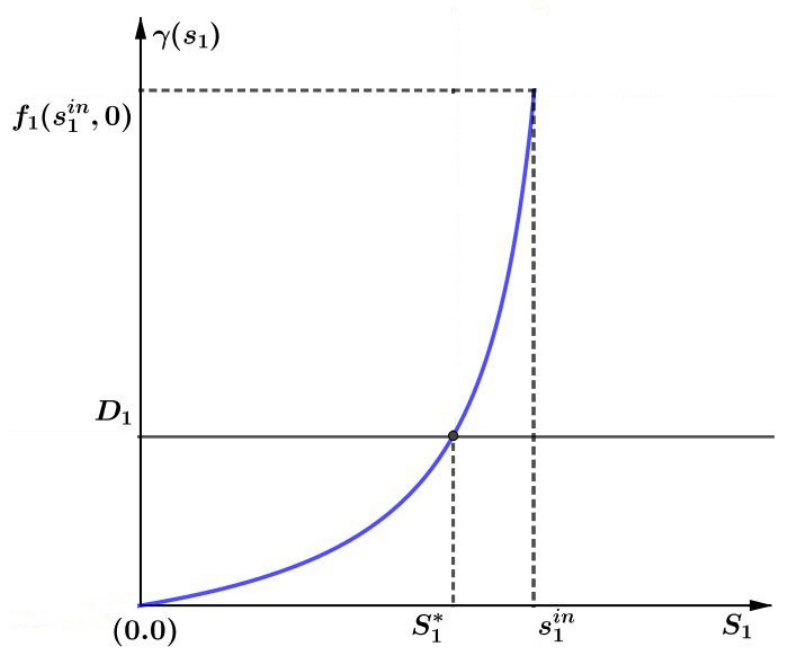
Figure 1. The existence of the solution of γ ( s 1 ) = D 1 .